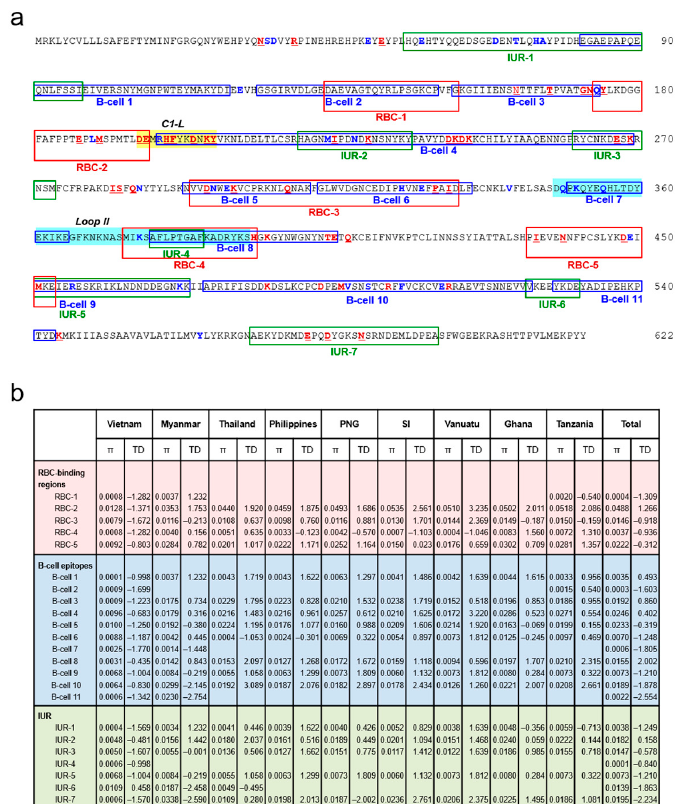
Figure 8. Association between natural selection and host immune pressure. ( a ) Positions of amino acid changes detected in global pfama-1 and predicted B-cell epitopes, RBC-binding regions, and IUR regions. Predicted B-cell epitopes, RBC-binding regions [44], and IUR regions [45] are represented by blue boxes, red boxes, and green boxes, respectively. Polymorphic amino acid residues commonly detected in global pfama-1 are marked as bold red. The less commonly detected amino acid changes are shown as bold blue. The C1-L (cluster 1 of loop I, aa: 196–207) in DI, and the loop II (aa: 348–392) in DII are marked with yellow and sky-blue squares, respectively. ( b ) Nucleotide diversity and natural selection analysis. Nucleotide diversity ( π ) and Tajima’s D (TD) values for each B-cell epitope region, RBC-binding region, and IUR region in global pfama-1 were analyzed using DnaSP program. PNG, Papua New Guinea; SI, Solomon Islands. The global patterns except Vietnamese pfama-1 have been analyzed previously [25], and the previous data were applied to analyze overall